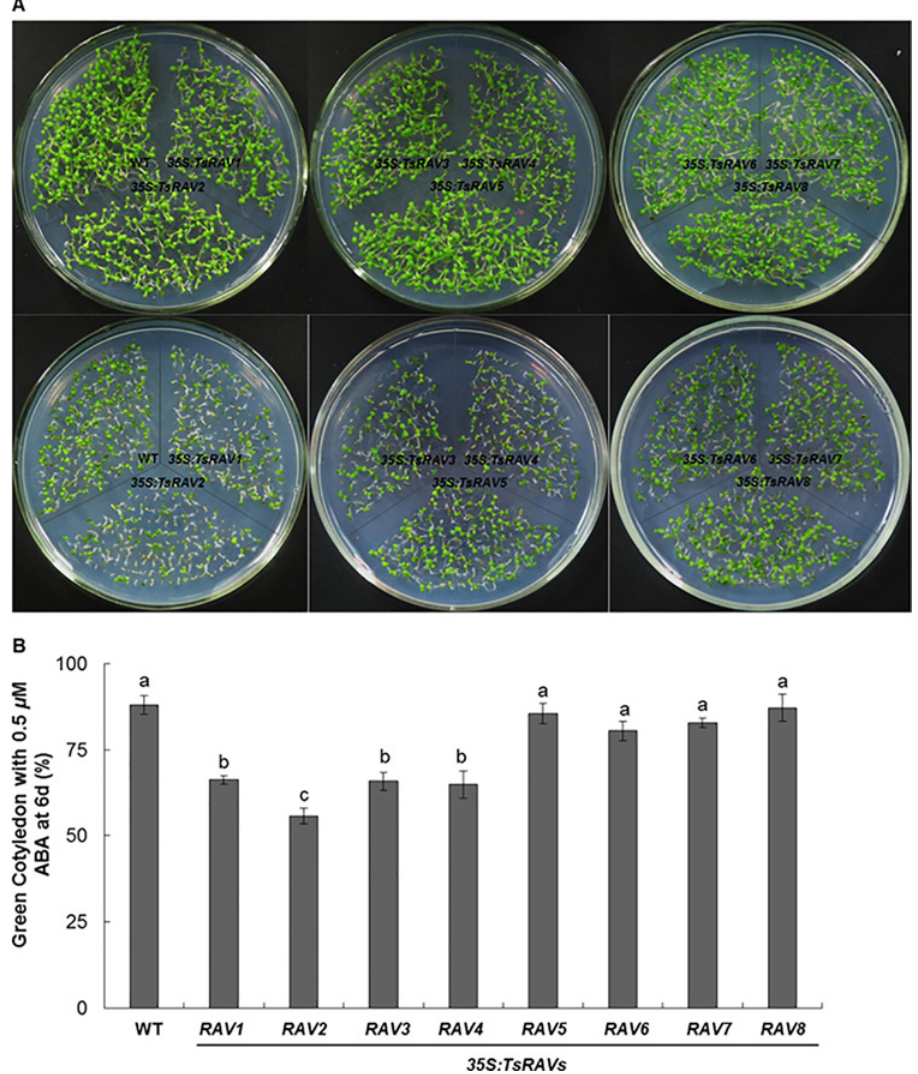
Fig 6. Cotyledon-greening analysis on 35S : TsRAVs transgenic Arabidopsis seedlings. (A) Phenotypic comparison of wild-type and 35S : TsRAVs transgenic Arabidopsis seedlings after grown on normal 1/2 MS medium (upper panel) or on 1/2 MS medium with 0.5 μ M ABA for 6 days (lower panel). (B) Cotyledon- greening percentages of 35S : TsRAVs transgenic Arabidopsis seedlings after grown on 1/2 MS medium with 0.5 μ M ABA for 6 days. Each data bar represents the mean ± SE of three replicates. More than 100 seeds were measured in each replicate. Different letters indicate significant differences among means ( P < 0.05 by Tukey ’ s